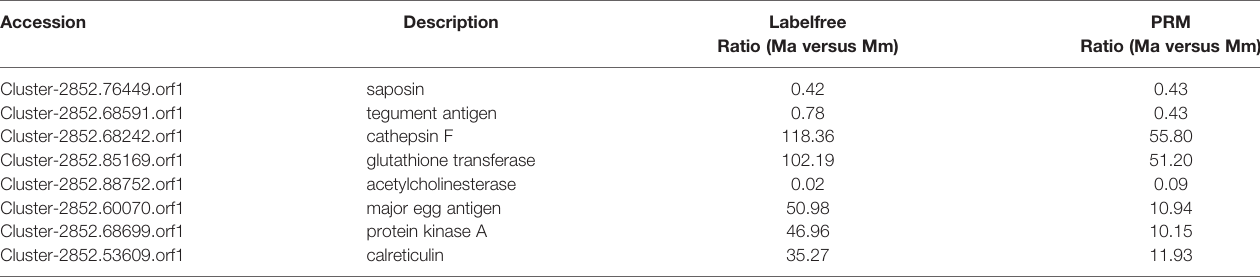
TABLE 3 | Con fi rmation of DEPs detected in label-free analyses using PRM assay.